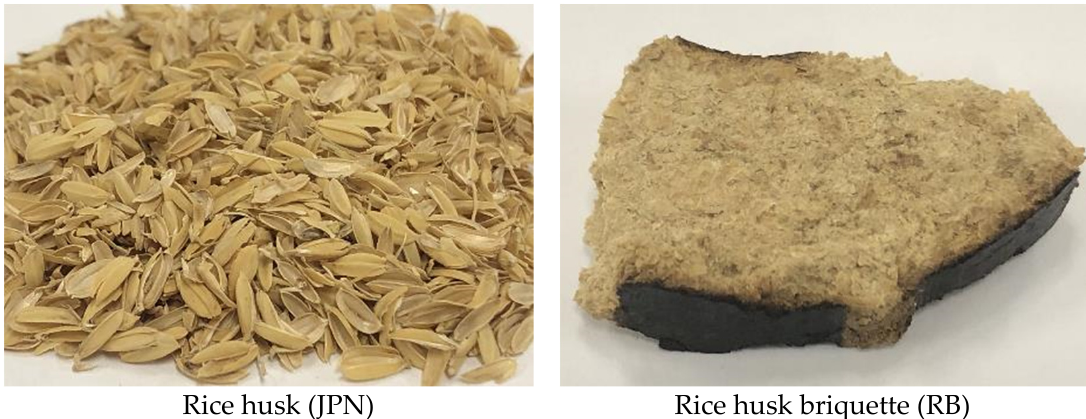
Figure 1. Images of JPN and RB samples prepared for combustion experiments.